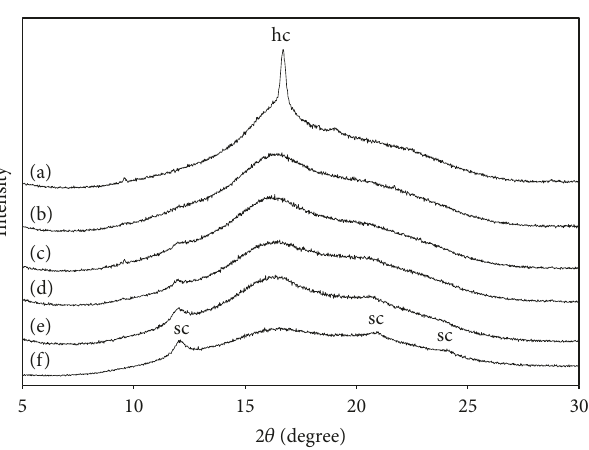
peaks and (cid:2) H values as c c Figure 3: XRD patterns of blend films with PLLA-PEG- PLLA/PDLA-PEG-PDLA ratios of (a) 100/0, (b) 90/10, (c) 80/20, (d) 70/30, (e) 60/40, and (f) 50/50